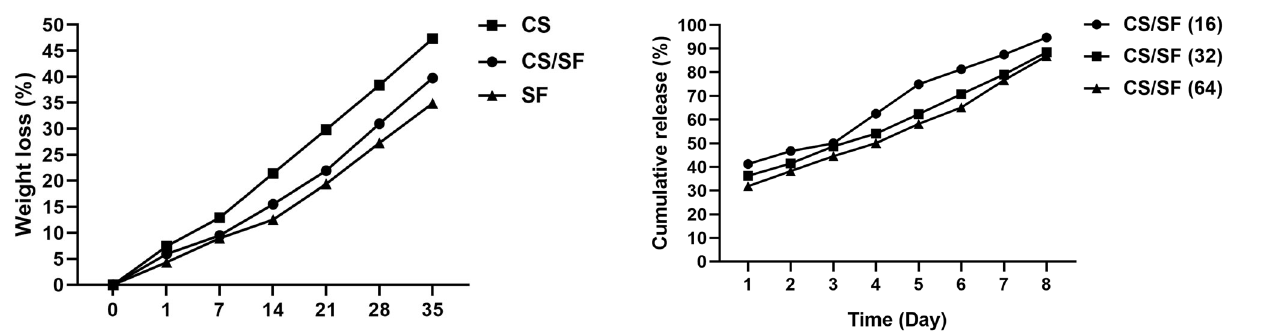
Fig. 5 The release pattern of CM11 peptide from the scaffolds. A burst release of the peptide at day 1, and an increase in a linear manner until day 8 is evident in the fi gure in all samples. Approximately 90% of the peptide is released through 8 consecutive days from all three experi- mental